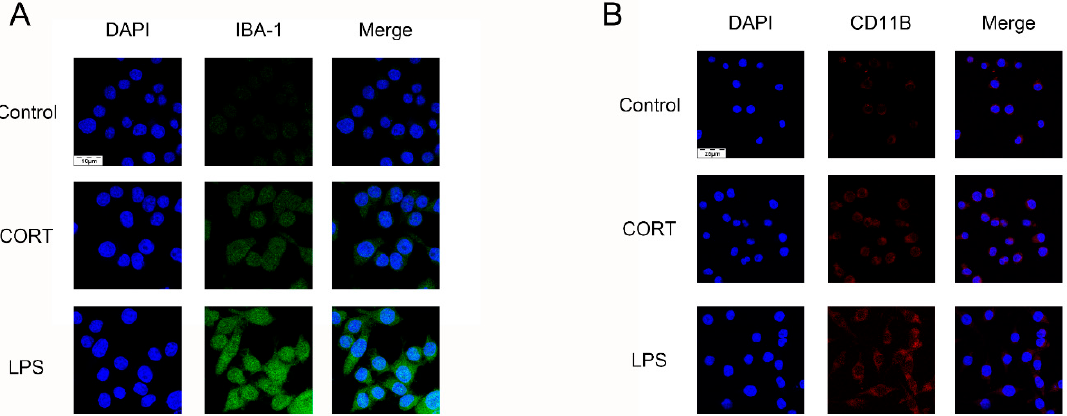
Figure 9. mRNA expression of inflammatory cytokines and e ff ects of cortisol (CORT) on the viability of BV2 cells. ( A ) Interleukin (IL)-1 β mRNA level in BV2 cells following treatment with indicated concentrations of CORT (0–400 µ M) for 3 h was evaluated by quantitative real-time (qRT)-PCR; cells treated with lipopolysaccharides (LPS) (1 µ g / mL) served as a positive control. Di ff erences among control, CORT, and LPS groups were evaluated by one-way analysis of variance. Results are expressed as the mean ± SD ( n = 3) of three independent experiments. N.S.: not significant; *** p < 0.001. ( B , C ) BV2 cells were treated with di ff erent concentrations of CORT (0–500 µ M) for 3 h and viability was assessed with the cell counting kit (CCK)-8 assay, and cells treated with LPS served as a positive control. Di ff erences among control, CORT, and LPS groups were evaluated by one-way analysis of variance. Results are expressed as the mean ± SD ( n = 3) of three independent experiment. N.S.: not significant; ** p < 0.01; *** p < 0.001.